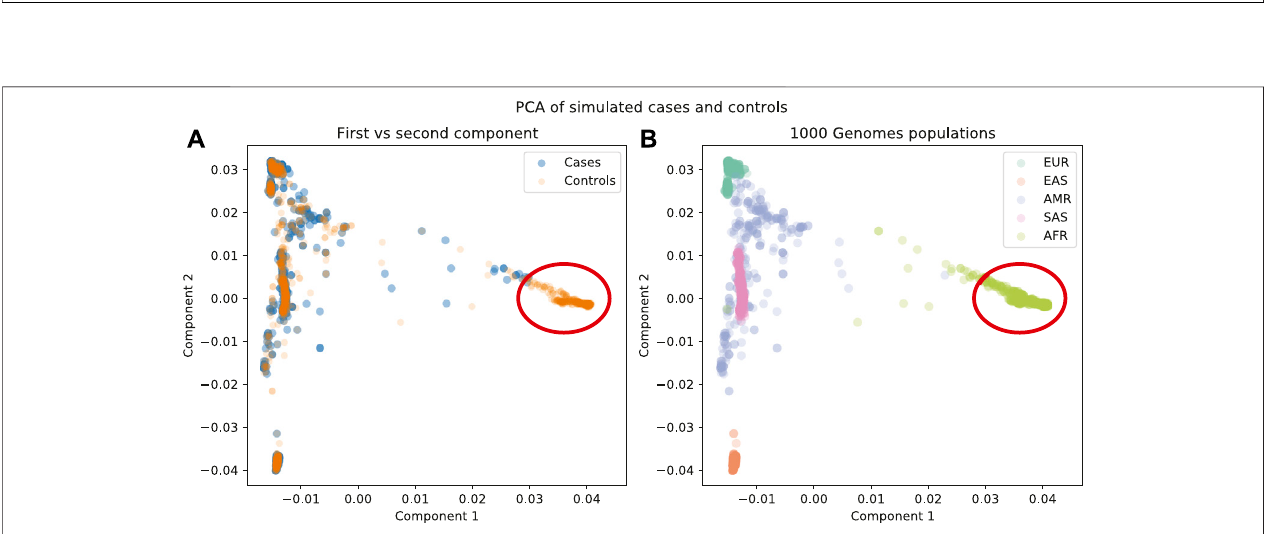
FIGURE 5 | Comparison between admixture of cases and controls of simulated data according to a run of ADMIXTURE with K (cid:1) 5. In these data, there is a super population that is underrepresented in the cases. (A) Admixture plot sorted by population label on 1,000 Genomes. (B) Density plot for cases and controls on the probability of membership to each of the clusters of the ADMIXTURE run. Note that here, cluster c4 corresponds to the African population.